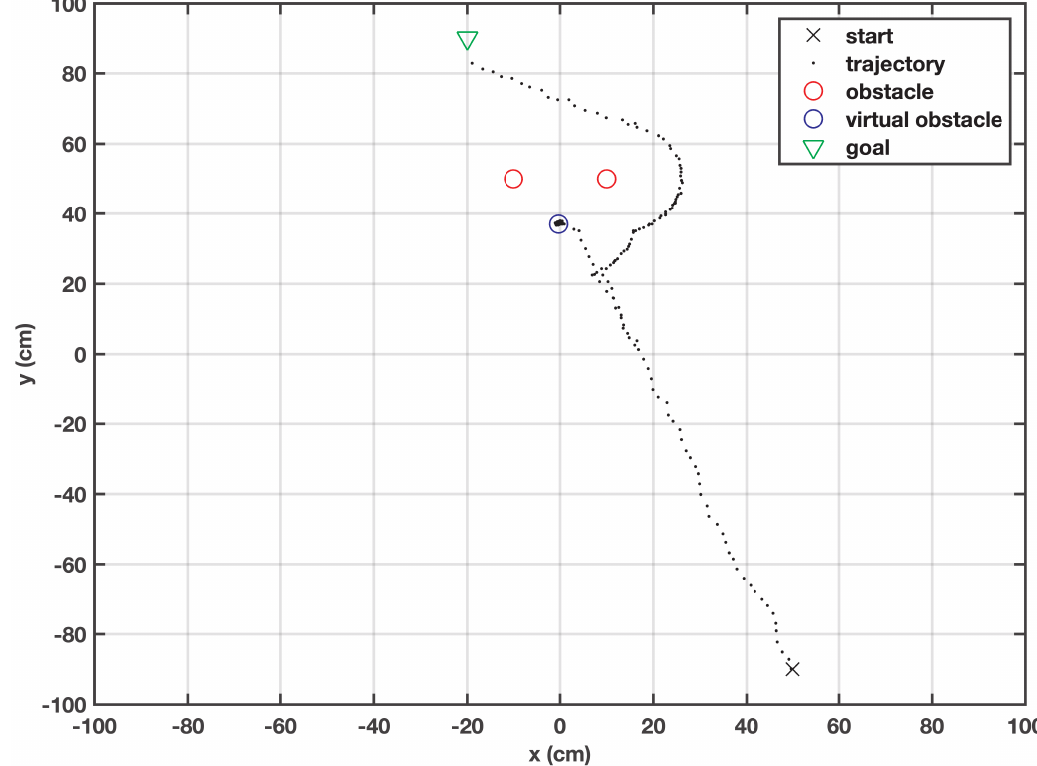
Figure 6. Behavior of the robot when local minima is encountered due to the close